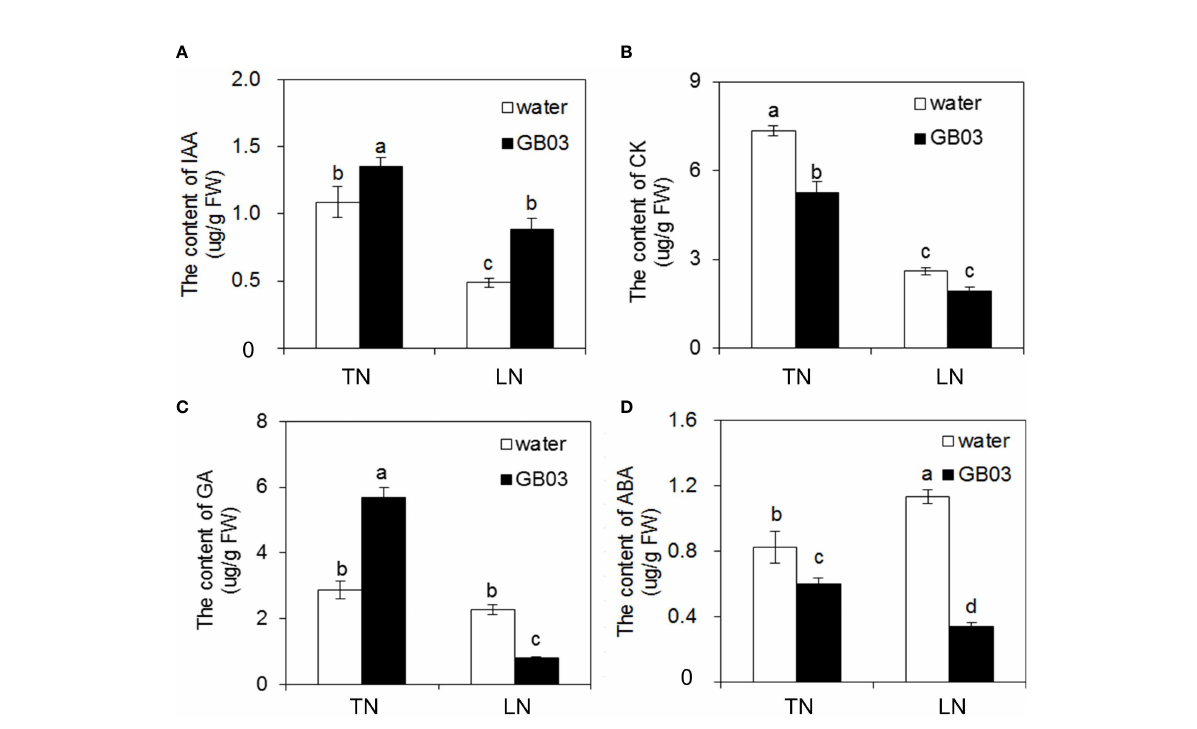
FIGURE 4 Effects of GB03 on phytohormone content in tall fescue under various concentrations of NO 3- . (A) Indole-3-actetic acid (IAA) content, (B) cytokinin (CK) content, (C) gibberellic acid (GA) content, and (D) abscisic acid (ABA) content. Values are means ± SE ( n = 9), and bars indicate SE. Columns with different letters indicate signi fi cant differences at p < 0.05 (Duncan ’ s